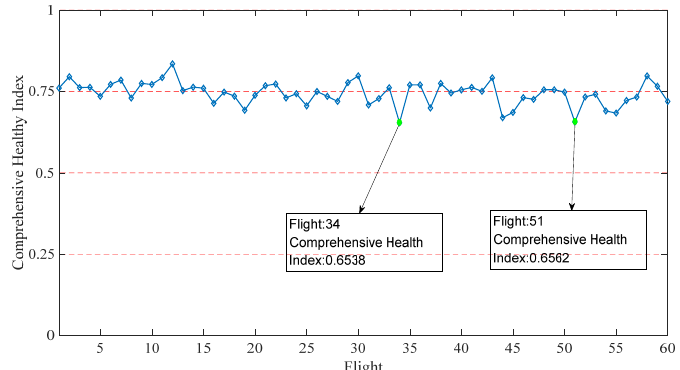
Figure 9. Health index of each channel.